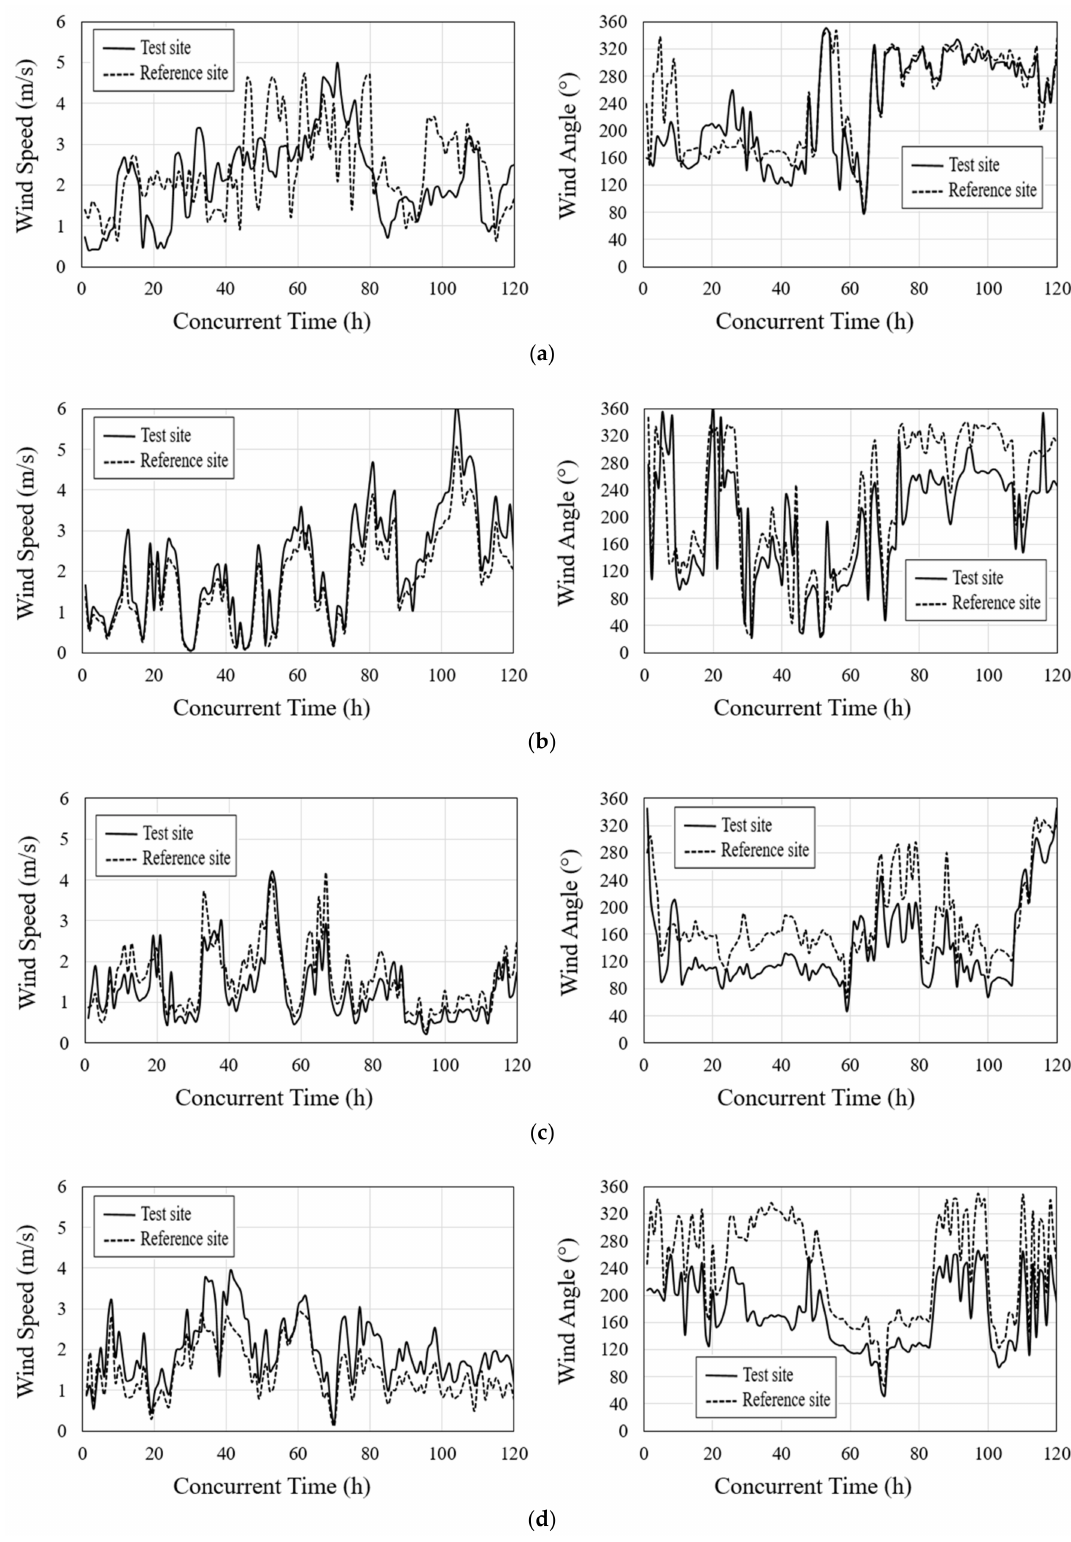
Figure 3. Wind data comparison at both sites over concurrent time period of five days for training year 2016. ( a ) Winter (1 January–5 January); ( b ) Spring (1 April–5 April); ( c ) Summer (1 July–5 July); ( d ) Autumn (1 October–5